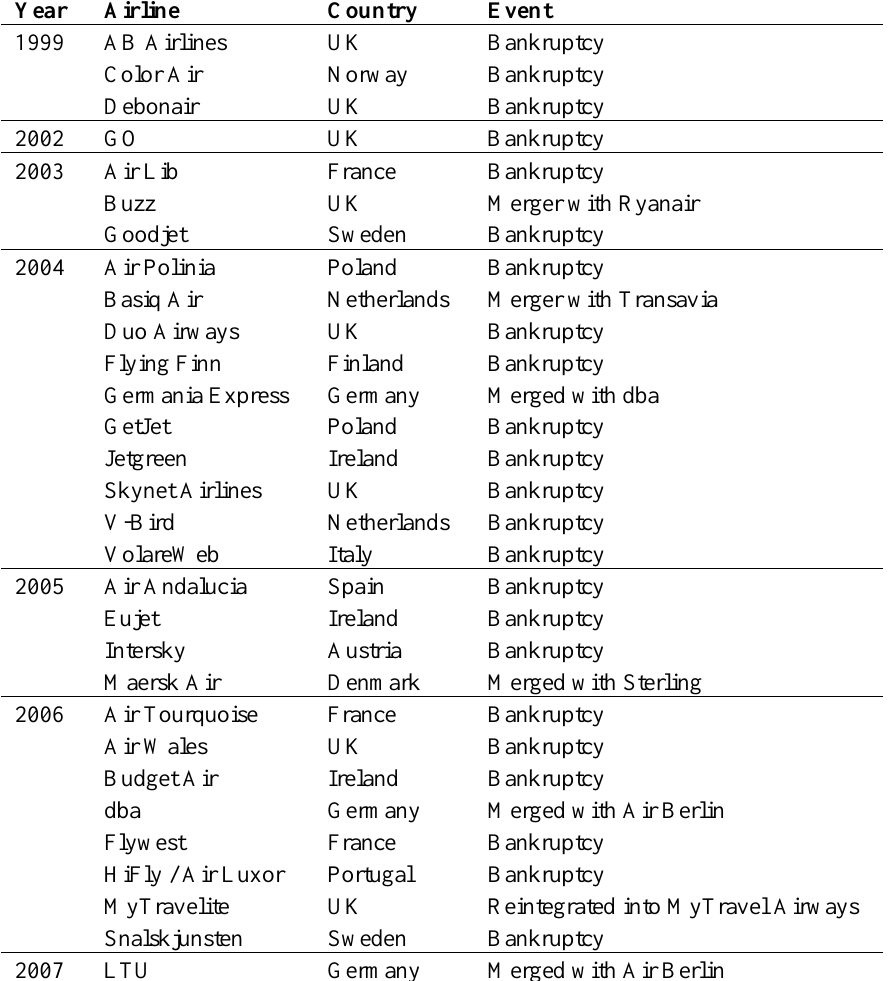
Table 8. Bankruptcies, mergers and takeovers in the European low-cost airlines